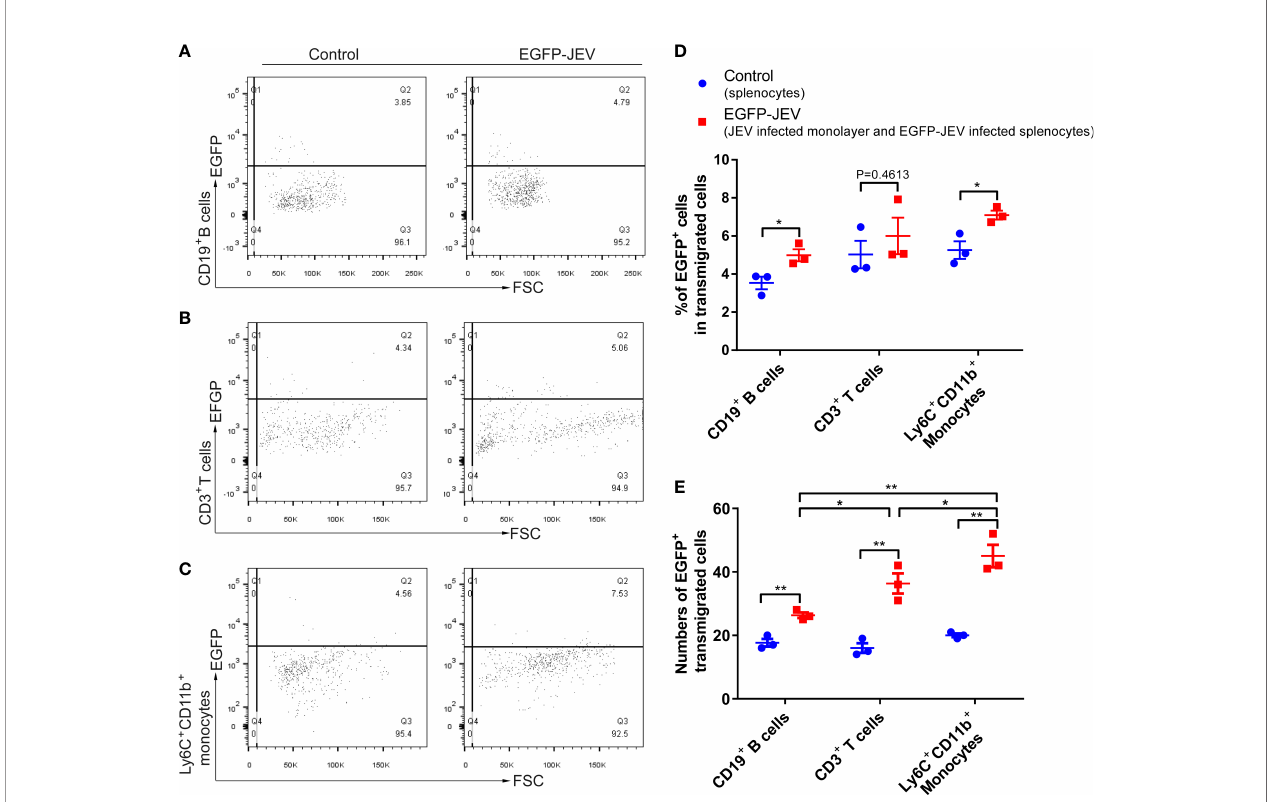
FIGURE 5 | Virus-carrying splenocyte transmigration in vitro . (A – C) JEV-infected bEnd.3 cell monolayers were cocultured with EGFP-JEV-infected splenocytes (5 × 10 5 ) for 24 h, and the transmigrated cells (lower chamber) were collected and measured by fl ow cytometry. An enhanced sensitivity measure at 488 nm was performed for the detection of intracellular EGFP-JEV in CD19 + B cells, CD3 + T cells, and Ly6C + CD11b + monocytes by fl ow cytometry. EGFP-JEV free cells were the nonspeci fi c control. (D , E) The statistical analysis of EGFP-positive cells in the transmigrated cells in the lower chamber reported in (A – C) . The experiments were repeated at least three times. The data are expressed as the means ± SEM. p > 0.05 (ns, no signi fi cant difference), * p < 0.05 and ** p <